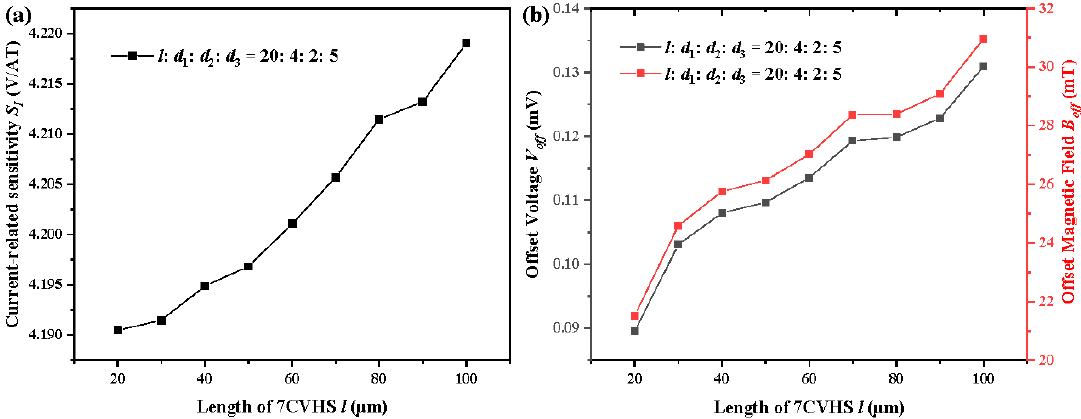
Figure 5. Current-related sensitivity S I ( a ), offset voltage V off and offset magnetic field B off ( b ) of various lengths of the 7CVHS from 20 to 100 µ m. The ratio of values of l , d 1 , d 2 and d 3 is always maintained at